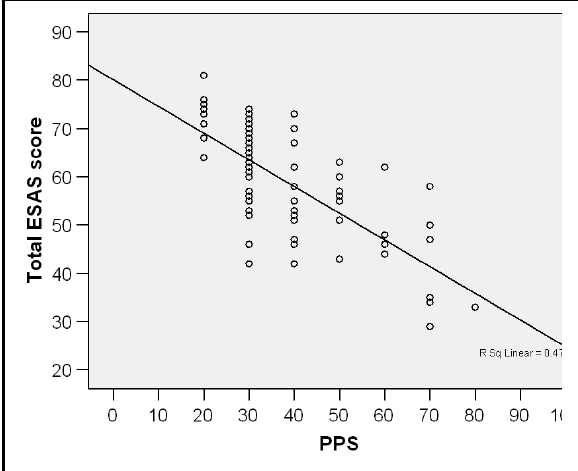
Figure 2: Correlation between the total ESAS-r score and PPS score